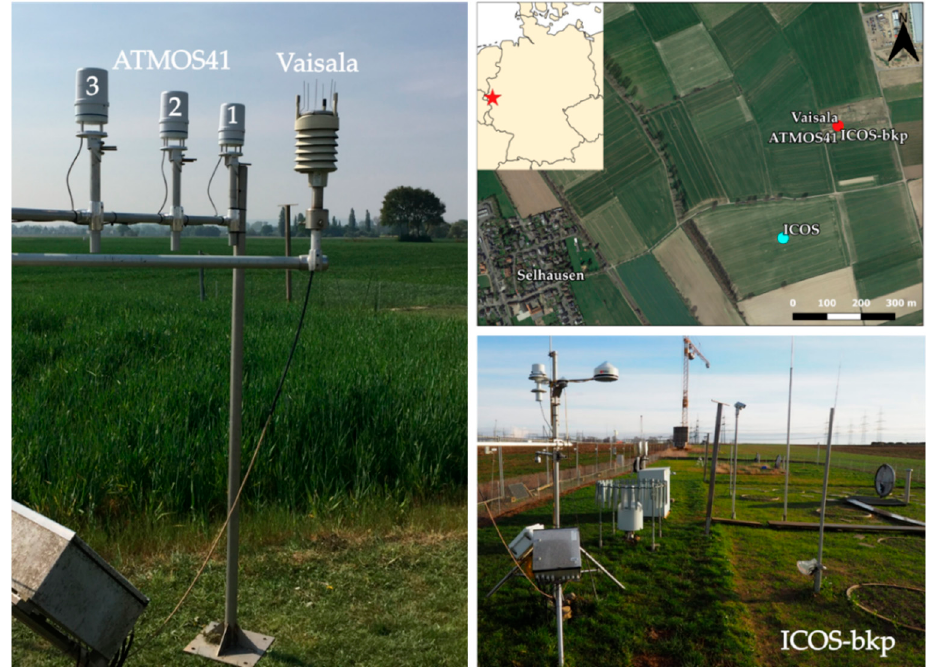
Figure 1. Experimental site with the three ATMOS41 stations, the Vaisala weather transmitter and the ICOS-bkp station.